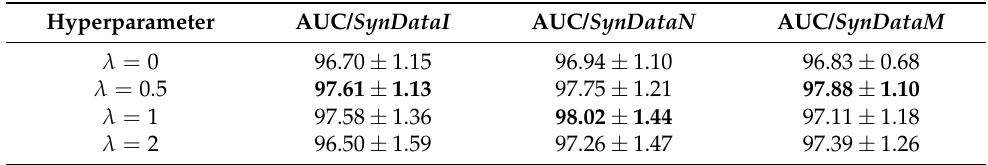
Table 2. AUC performance of the GPGDA algorithm with different values of hyperparameter λ from 0 to